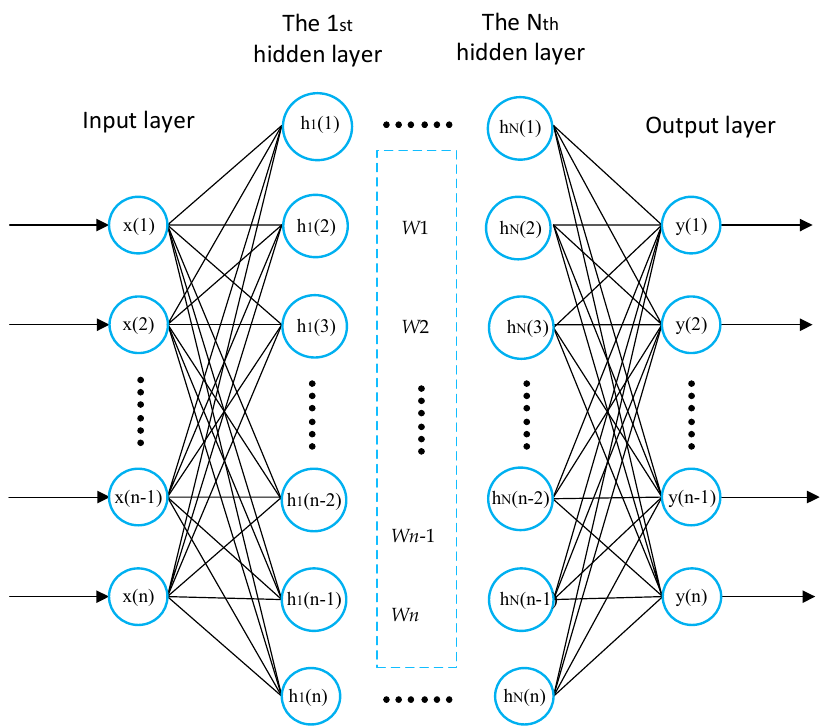
Figure 5. Deep neural network algorithm structure diagram.